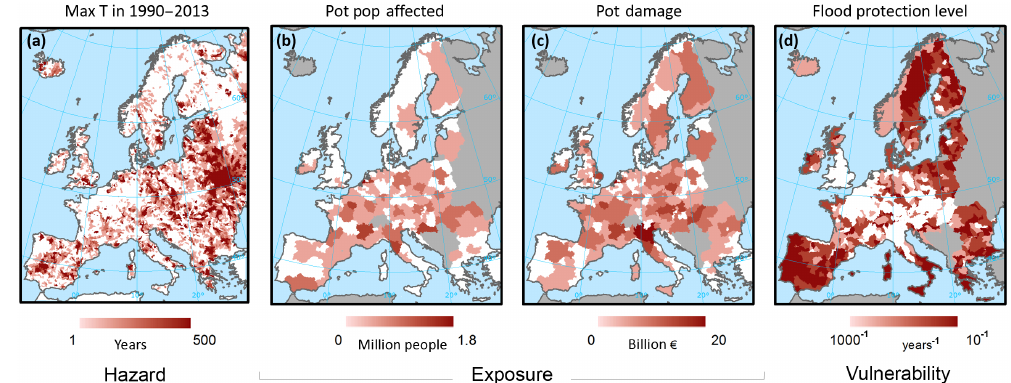
Figure 3. Modelled factors contributing to the overall flood risk: maximum simulated flood return period ( T ) within 1990–2013 (a) ; potential population affected by a flood with a 100-year return period (b) ; potential damage of a flood with a 100-year return period (c) ; return period of flood protection levels (d) .